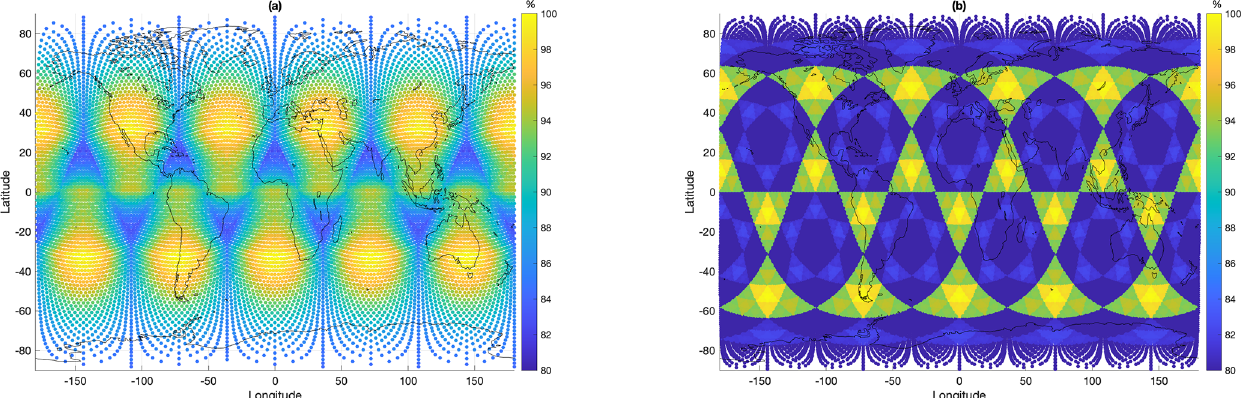
Figure 2. (a) Triangle area for the spline triangular grid (Wang and Dahlen, 1995) and (b) the icosahedron grid (Pasyanos et al., 2014). Both grids were evaluated in terms of geodesics (triangle sides are treated as great circles on the sphere) and both panels shows the area variation in percent (%) with respect to the largest